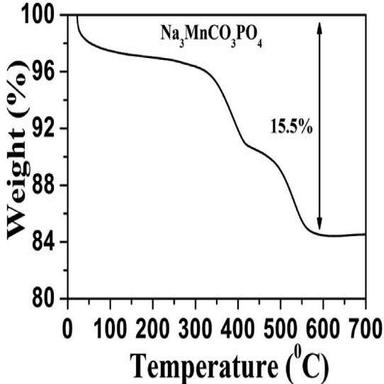
TGA profile of Na3MnCO3PO4 cathode material.